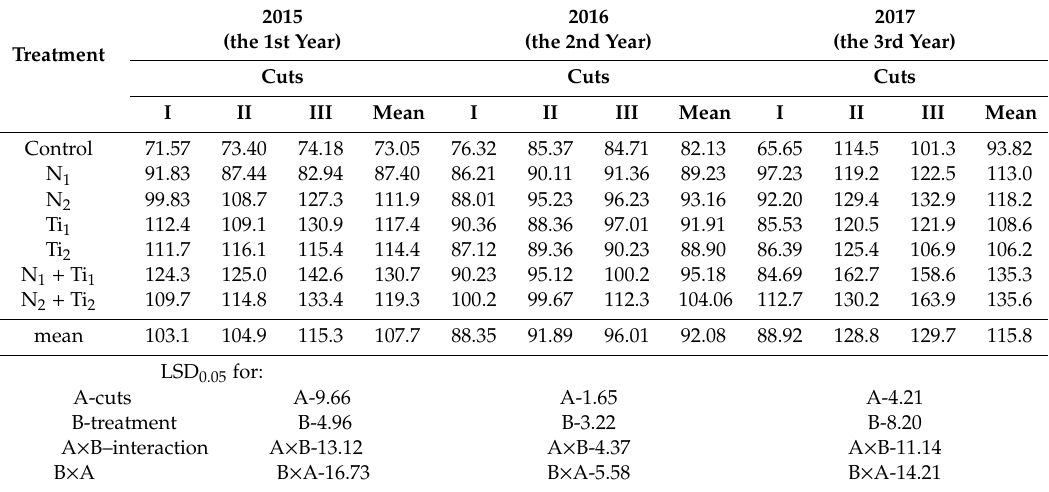
Table 3. Total protein content in Festulolium braunii (g kg − 1 DM).